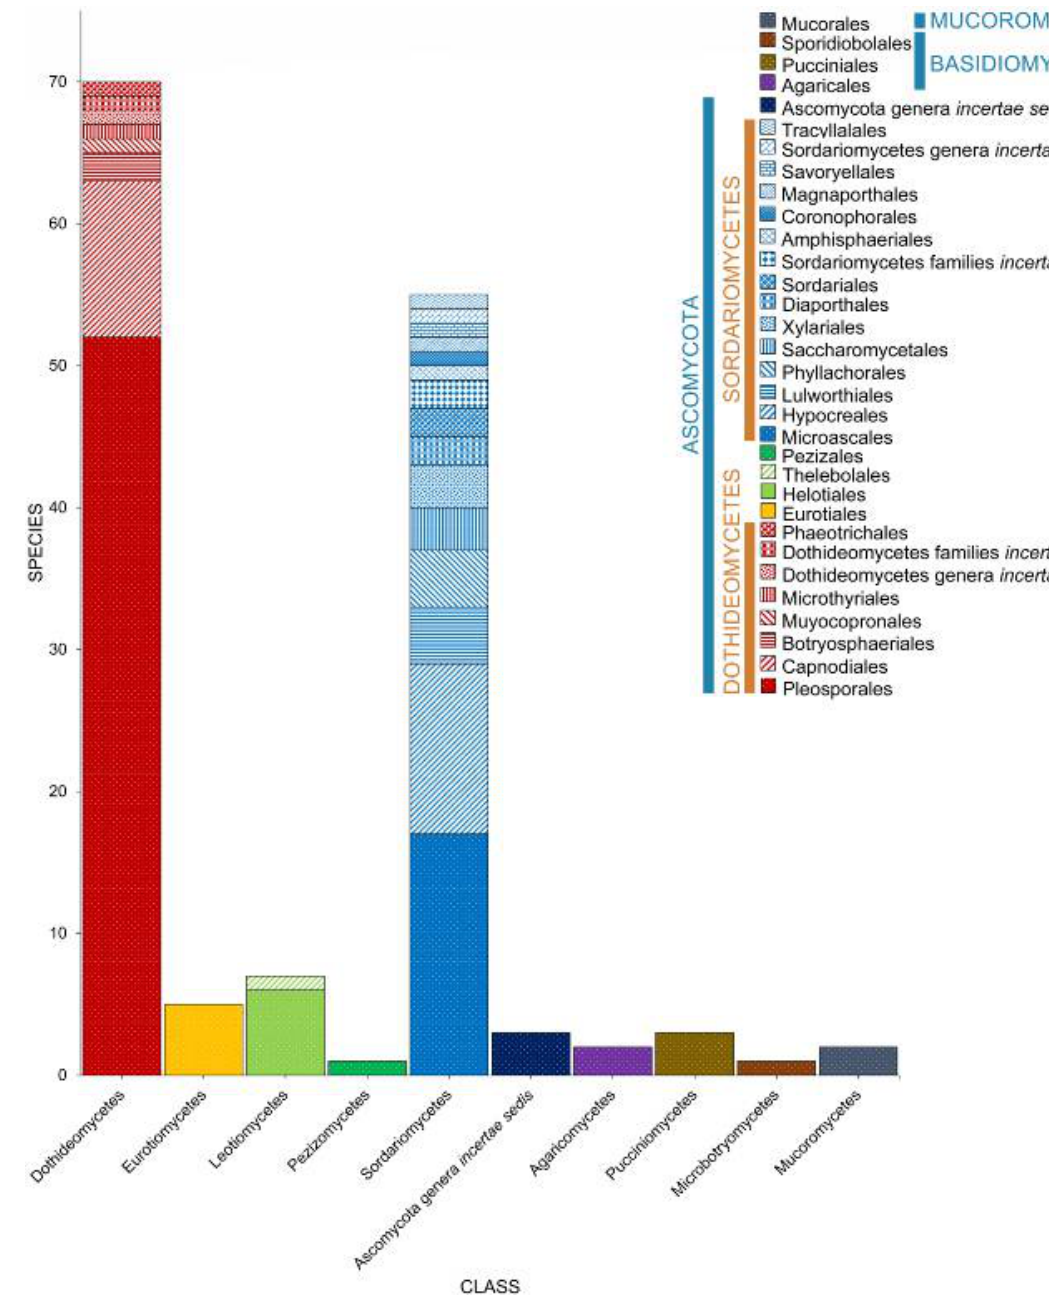
Figure 11. The distribution of fungal taxa associated with Spartina . Halobyssothecium obiones was recorded from six species of Spartina ( S. alterniflora [20,35, 52,61,71,74,80–82], S. cynosuroides [35], S. densiflora [64], S. maritima [31,54,59,63], S. patens [36], S. townsendii [49,65], and the unidentified Spartina sp. [32,35,36,58,84]), while six Spartina spp. harbors unidentified Mycosphaerella species. Six species ( Leptosphaeria pelag- ica , Lulworthia spp., Phaeosphaeria halima , Phaeosphaeria spartinicola , Phoma spp., Stagonospora spp.) were recorded in five different hosts. The unidentified Spartina species harbors 28 unique species. Amongst the taxa found in Spartina , 32 species can only be found in S. alterniflora , while S. maritima harbors 21 unique species, the most intensively surveyed